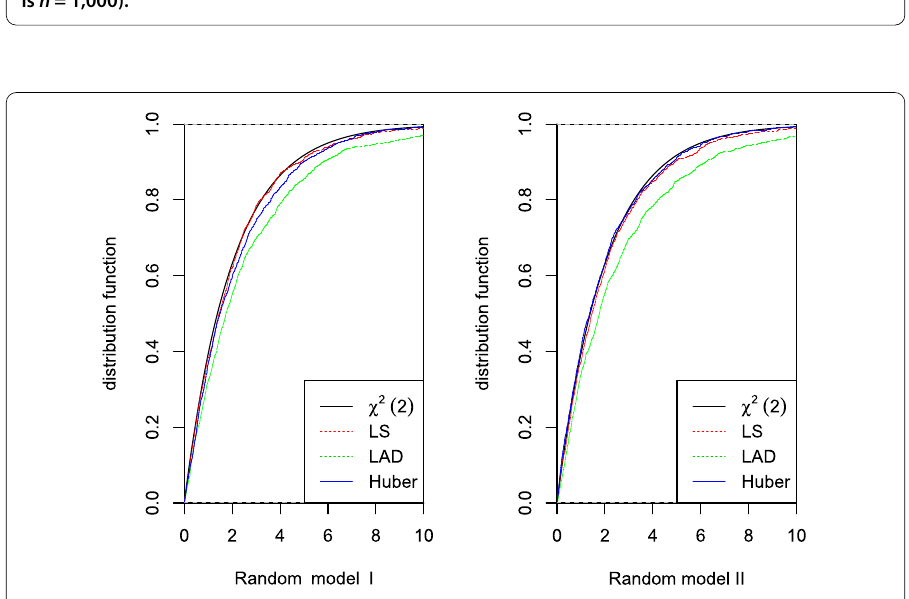
Figure 4 A comparison fitted distribution functions of 2 ˆ λ n ˆ σ 2 n M n and the central chi-squared distribution with two degrees (sample size is n =